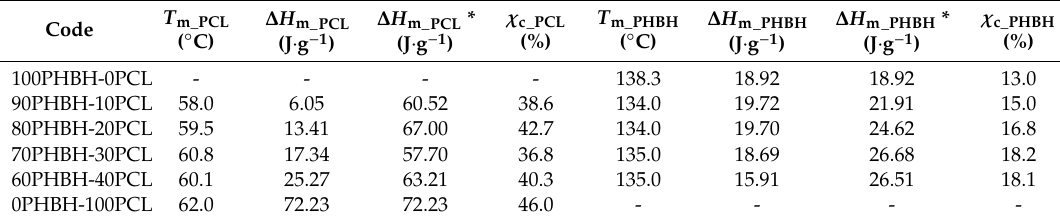
Table 2. Thermal properties of PHBH, PCL, and PHBH / PCL binary blends with di ff erent PCL wt % obtained during the 1st heating cycle after processing plus 15 aging days to complete secondary